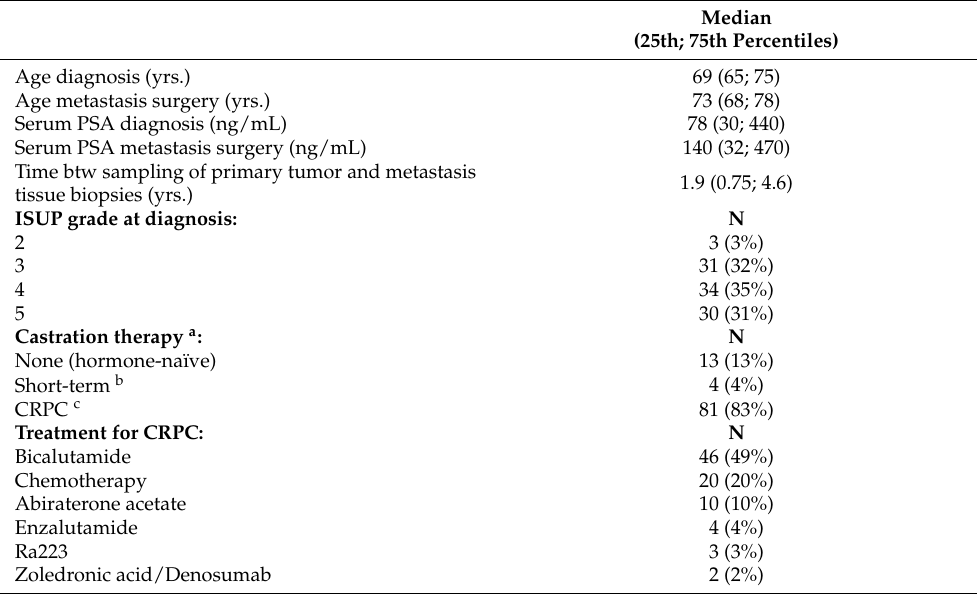
Table 1. Clinical characteristics of 98 patients with bone metastatic prostate cancer from whom paired metastatic and primary tumor tissue were